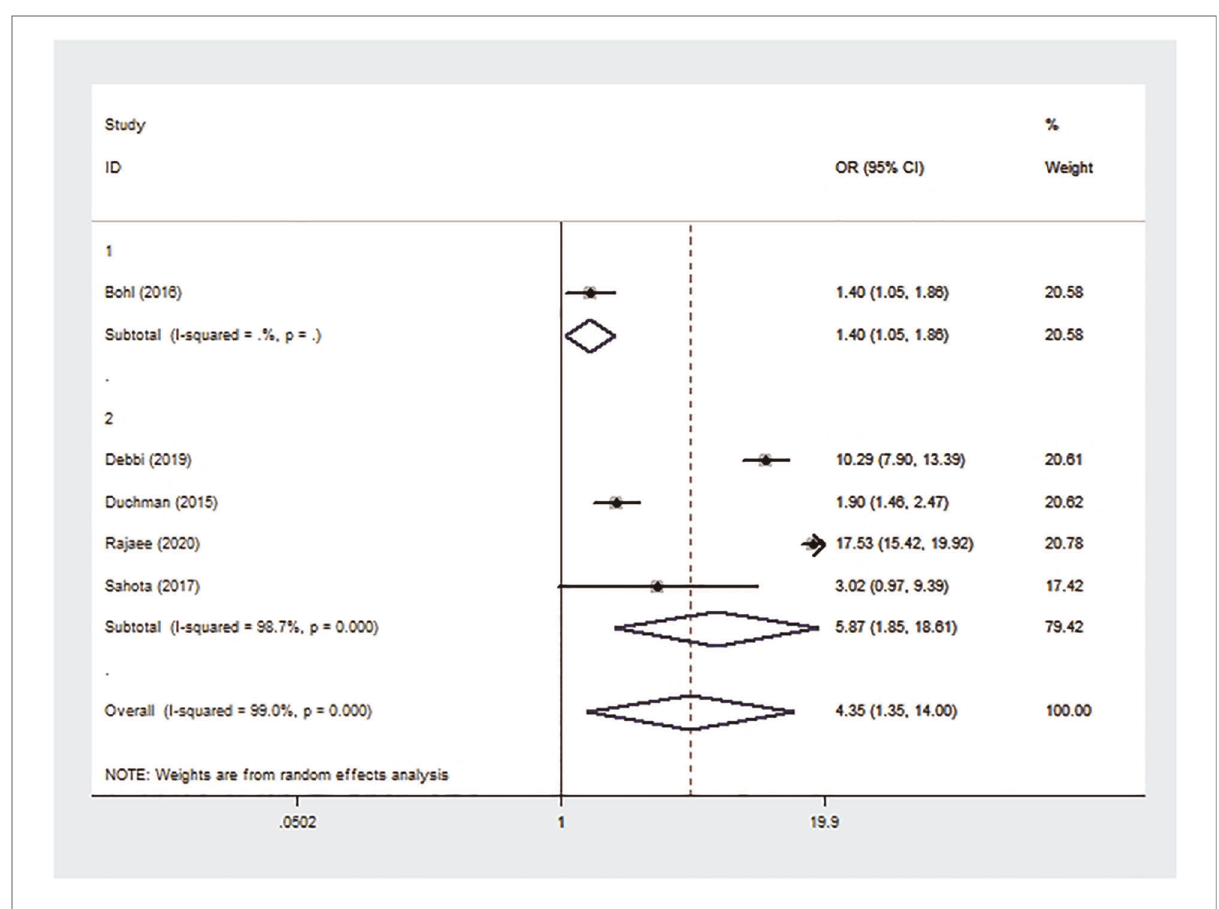
FIGURE 9 Forest plot of subgroup analysis for sepsis based on study type (1: case-control study; 2: cohort